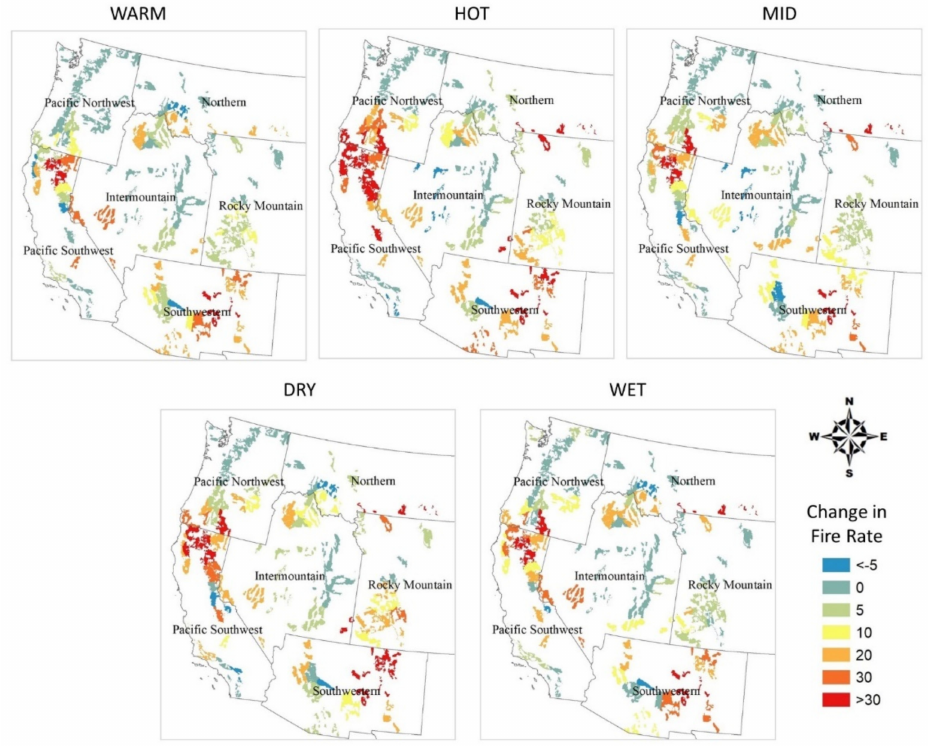
Figure 7. Changes in rate of major forest fires from historical (1986–2015) to future conditions (2070–2099) in western U.S.